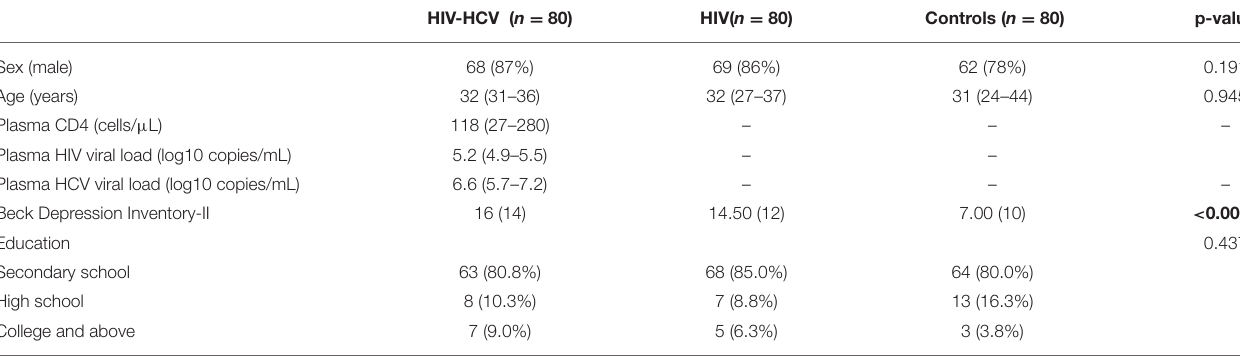
TABLE 1 | Baseline demographic and clinical